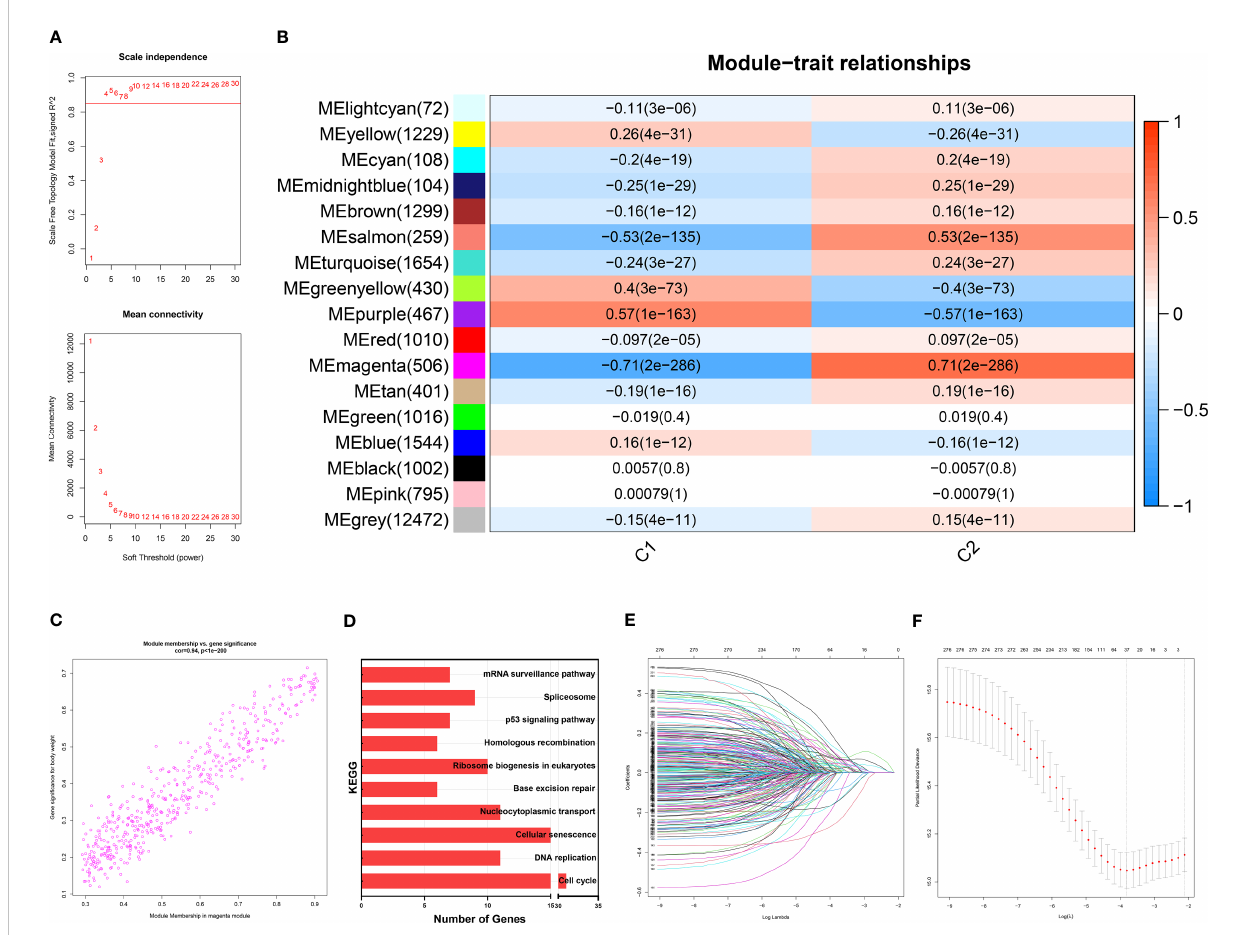
FIGURE 5 Identi fi cation of gene networks associated with CC1 and CC2 subtypes using WGCNA. (A) Analysis of the scale-free fi t index for various soft- thresholding powers ( b ). 6 was considered the fi ttest power value. (B) Heatmap of correlations between gene modules and CC1 and CC2 subtypes. (C) Scatter plot depicting the correlation between gene signi fi cance and gene module membership in the magenta module. (D) Bar plot showing the signi fi cant enrichment results for genes in magenta module on KEGG pathways. (E) Different gene combinations and corresponding LASSO coef fi cients. (F) Parameter selection in the LASSO (least absolute shrinkage and selection operator) model. Independent Con fi dence intervals under each lambda were